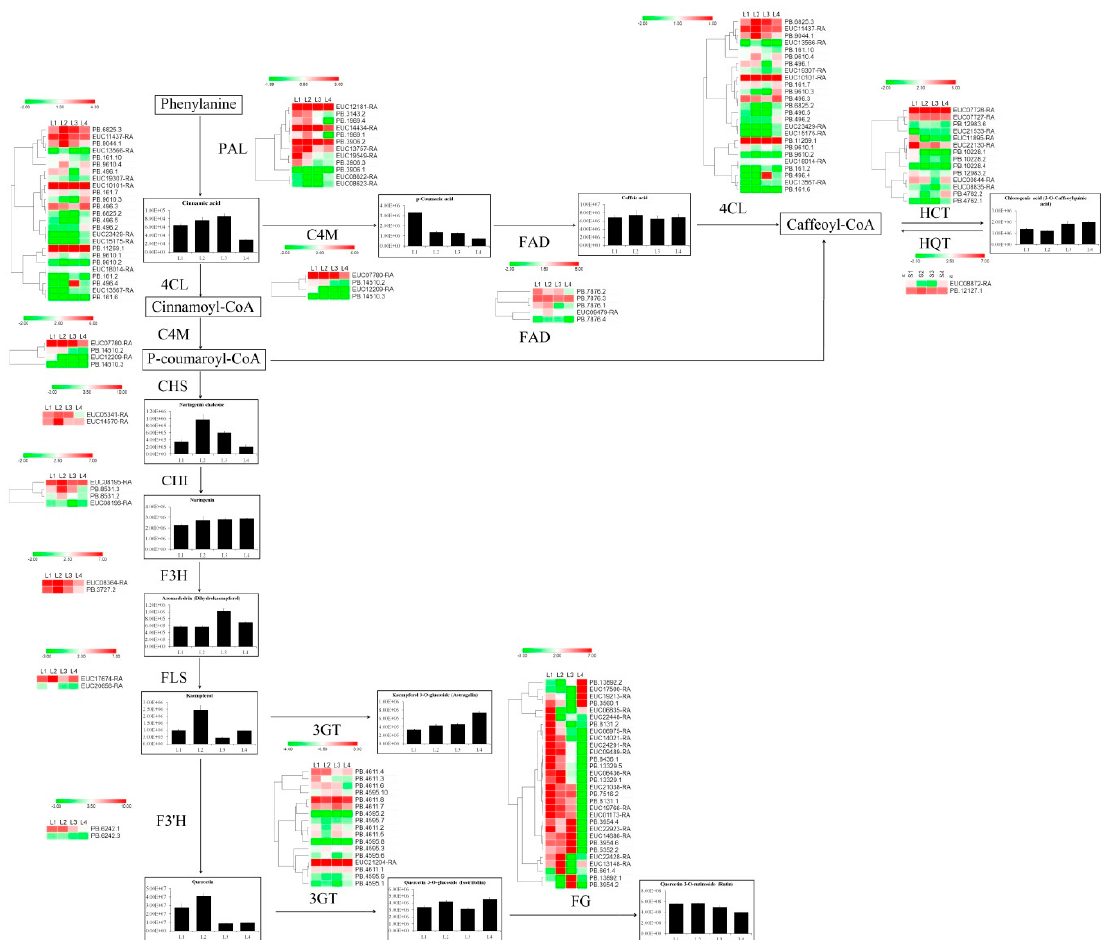
Figure 6. The principal pathways of flavonoid and phenylalanine biosynthesis during Eucommia ulmoides growth and development. These pathways were constructed based on Kyoto Encyclopedia of Genes and Genomes (KEGG) pathways and literary references. The words in the black box represent metabolites, and the metabolite levels are shown as histograms. Many macromolecular compounds, including cinnamoyl-CoA, p-coumaroyl-CoA and caffeoyl-CoA, were not detected by metabolomes. Arrows represent enzyme reactions; enzymes are shown next to the arrows. Heat maps next to the enzyme names indicate the expression value of isoforms across tissues (L1, L2, L3, and L4). The colour scale represents log2-transformed fragments per kilobase of transcript per million mapped reads (FPKM) values. Green indicates low abundance, and red indicates high abundance. The isoforms with an FPKM value less than 0.1 in all samples are not included in the heat map.